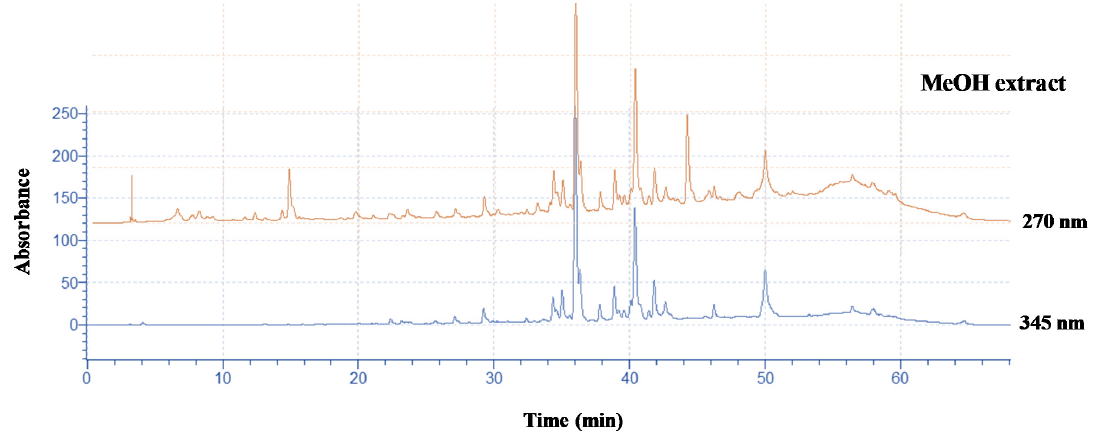
Figure 3. Chromatograms recorded at 270 and 345 nm, showing major polyphenolic constituents of OLL extracts. The upper figure displays the profile of the DES extract obtained under optimized conditions, at 80 °C and the lower figure is the profile of a control extract obtained with 60% methanol, at room temperature. Peak assignment: 1, hydroxytyrosol; 2, rutin;, 3, luteolin 7- O -glucoside; 4, apigenin 7- O -rutinoside; 5, luteolin 3 ′ - O -glucoside; 6, oleuropein; 7, quercetin; and, 8, apigenin.